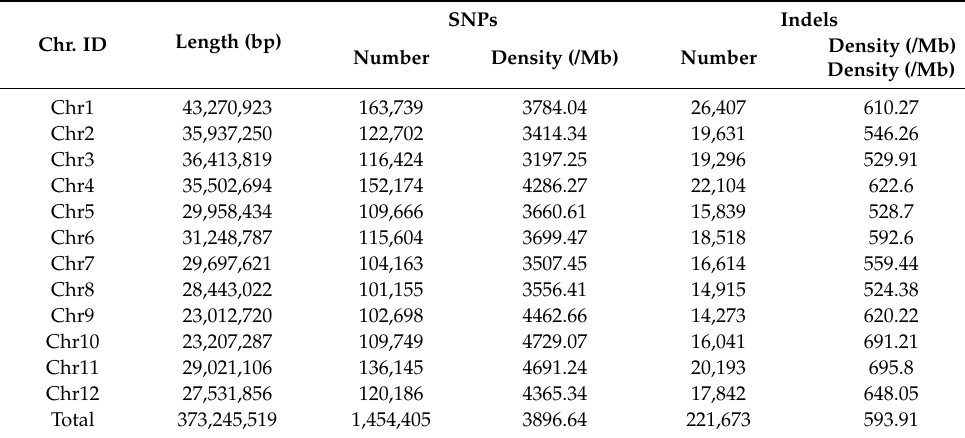
Table 1. Variation sites in DXWR obtained by